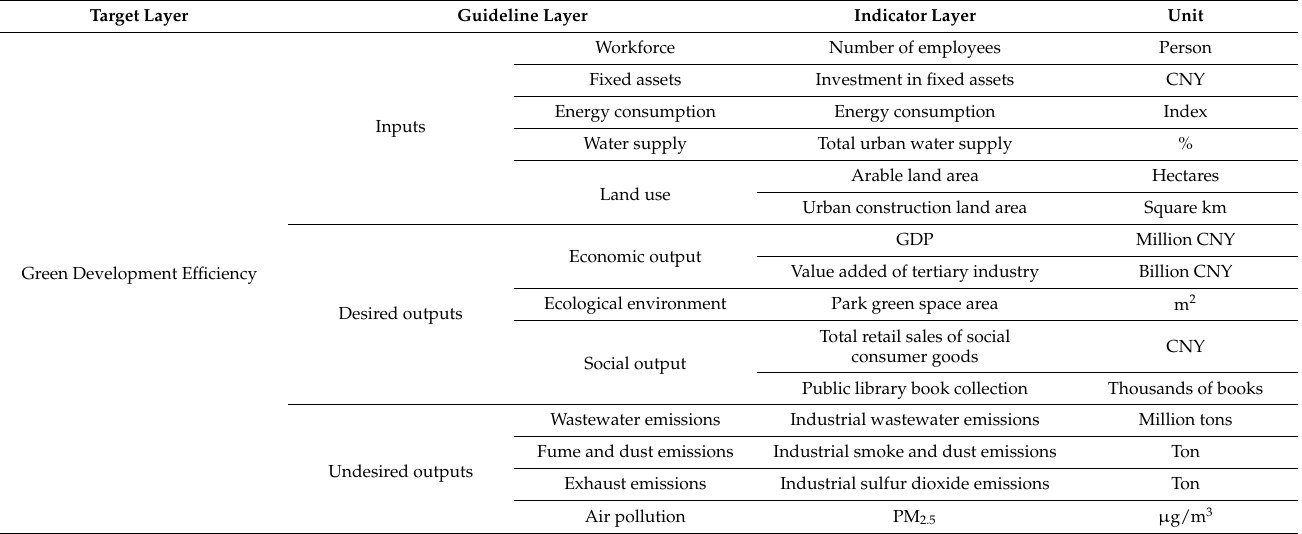
Table 2. Evaluation Index System for Green Development